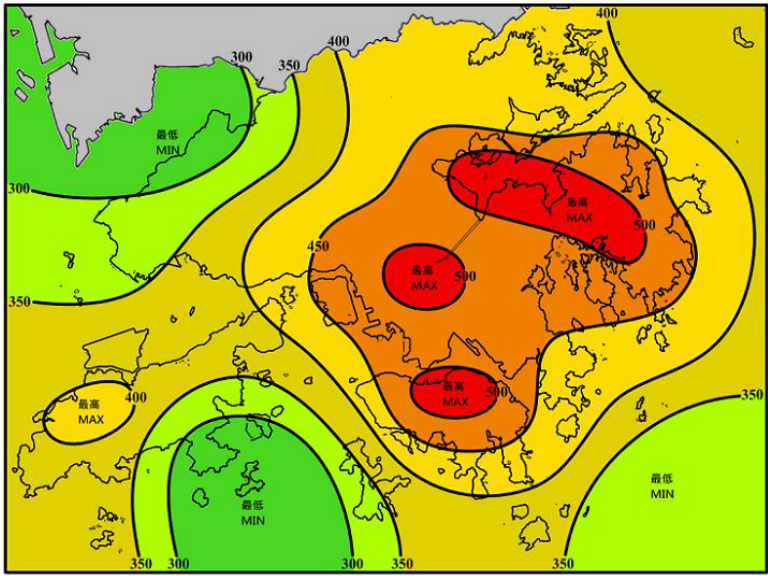
Figure 9. Precipitation map for August 2017 (isohyets are in mm).